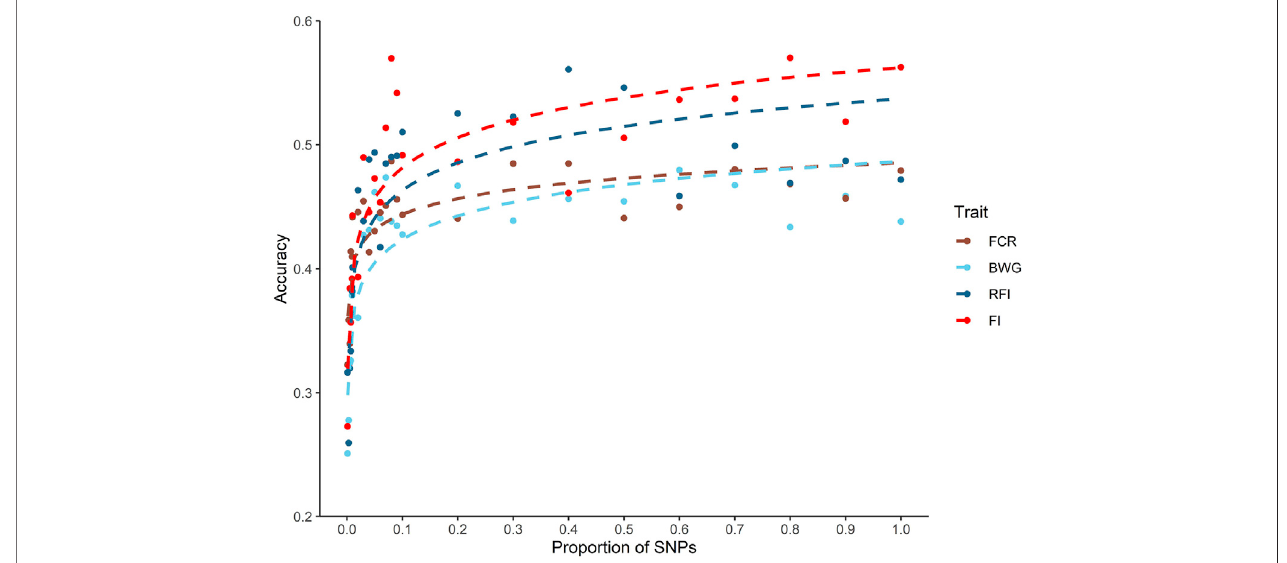
FIGURE 3 | Genomic prediction accuracies using different SNP densities for feed-ef fi ciency related traits in a Nile tilapia ( Oreochromis niloticus ) breeding population.PredictedaccuraciesachievedusingdifferentSNPlowdensitypanelsforfeedconversionratio(FCR),bodyweightgain(BWG),residualfeedintake(RFI)and feed intake (FI) using a genomic BLUP (GBLUP)